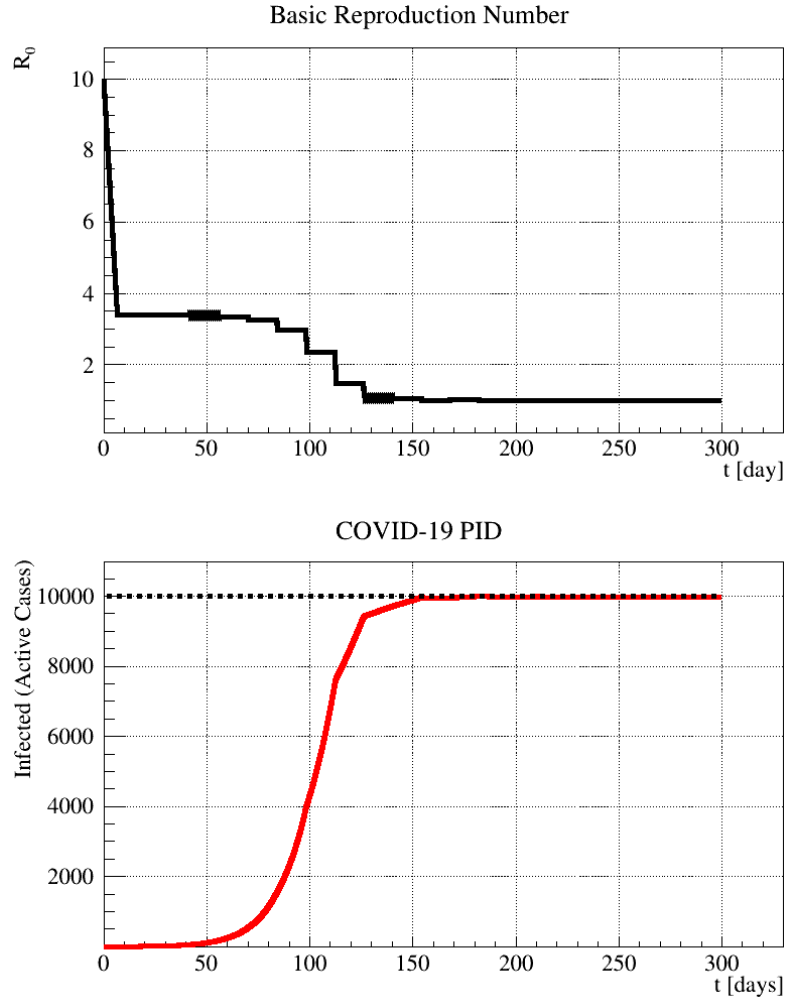
Figure 6. Example of PID controller simulation. Behaviour of ( top ) input basic reproduction number, R 0 , and ( bottom ) the output number of the infectious individuals, I ( t ) , with tuned K p = 2.4, K i = 0.04, and K d = 0.004. The dashed black line represents the set-point. The optimal tuning, which includes the integral and derivative term, allows reaching the set-point smoothly. This corresponds to a mild lockdown at the beginning and a subsequent fine tuning of the restriction corresponding to the final social distancing that can remain